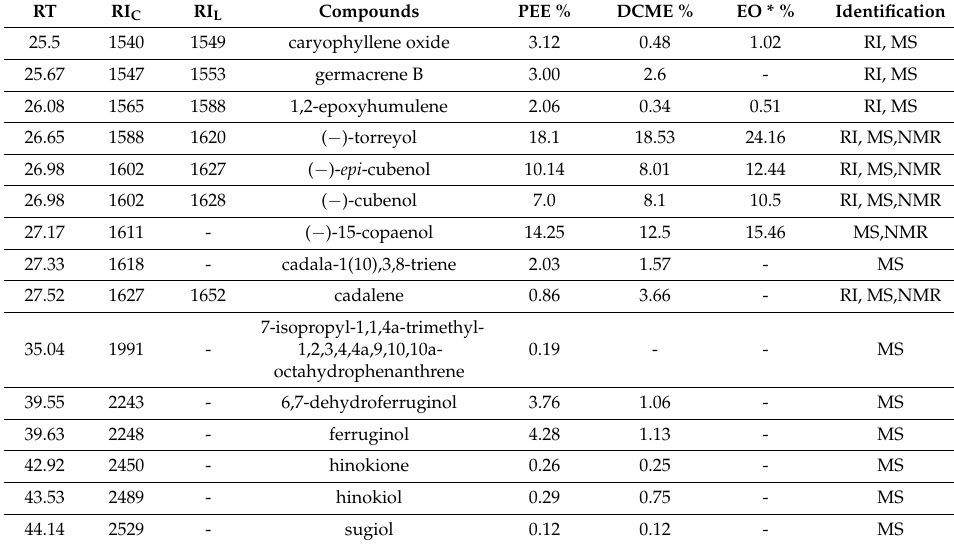
Table 2. 13 C-NMR data of sesquiterpenes isolated from P. uviferum (D. Don) Florin (100 MHz, CDCl 3 ). Carbon Number a